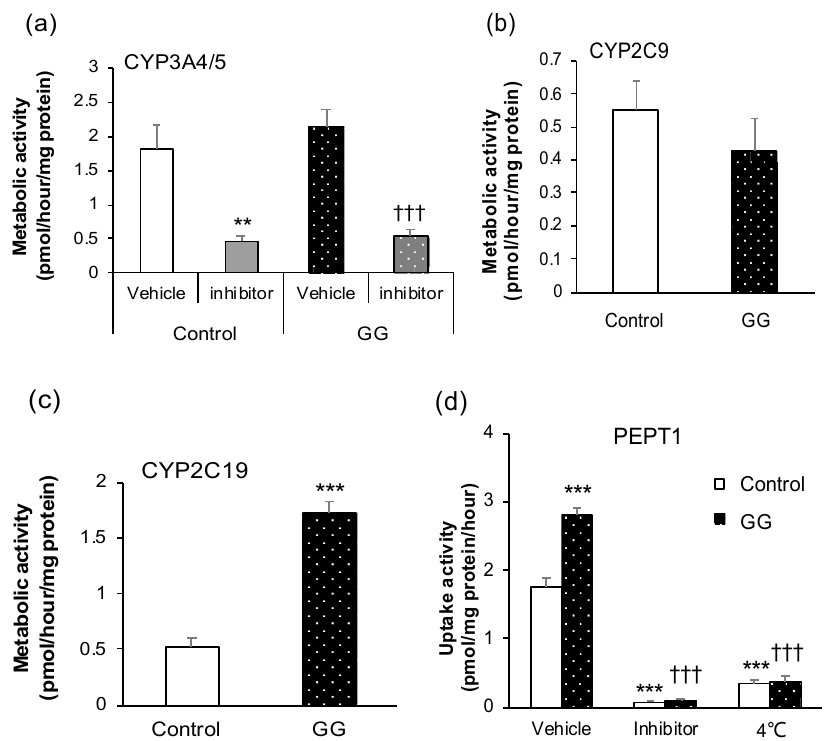
Figure 3. Pharmacokinetic functions in the di ff erentiated enterocytes. ( a ) Cytochrome P450 (CYP) 3A4 / 5 activity in the presence or absence of 10 µ M ketoconazole, a CYP3A4 inhibitor. ( b , c ) CYP2C9 and CYP2C19 activities. ( d ) Uptake activity via peptide transporter 1 (PEPT1). Ibuprofen was used as an inhibitor of PEPT1. All data are presented as mean ± S.D. ( n = 4). Levels of statistical significance compared with the control group (vehicle): ** p < 0.01, *** p < 0.001. Levels of statistical significance compared with the GG group (vehicle): ††† p <